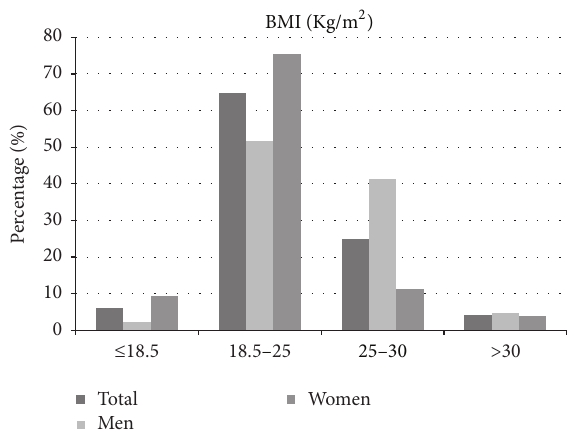
Figure 1: Distribution of BMI categories in all study participants and in men and women